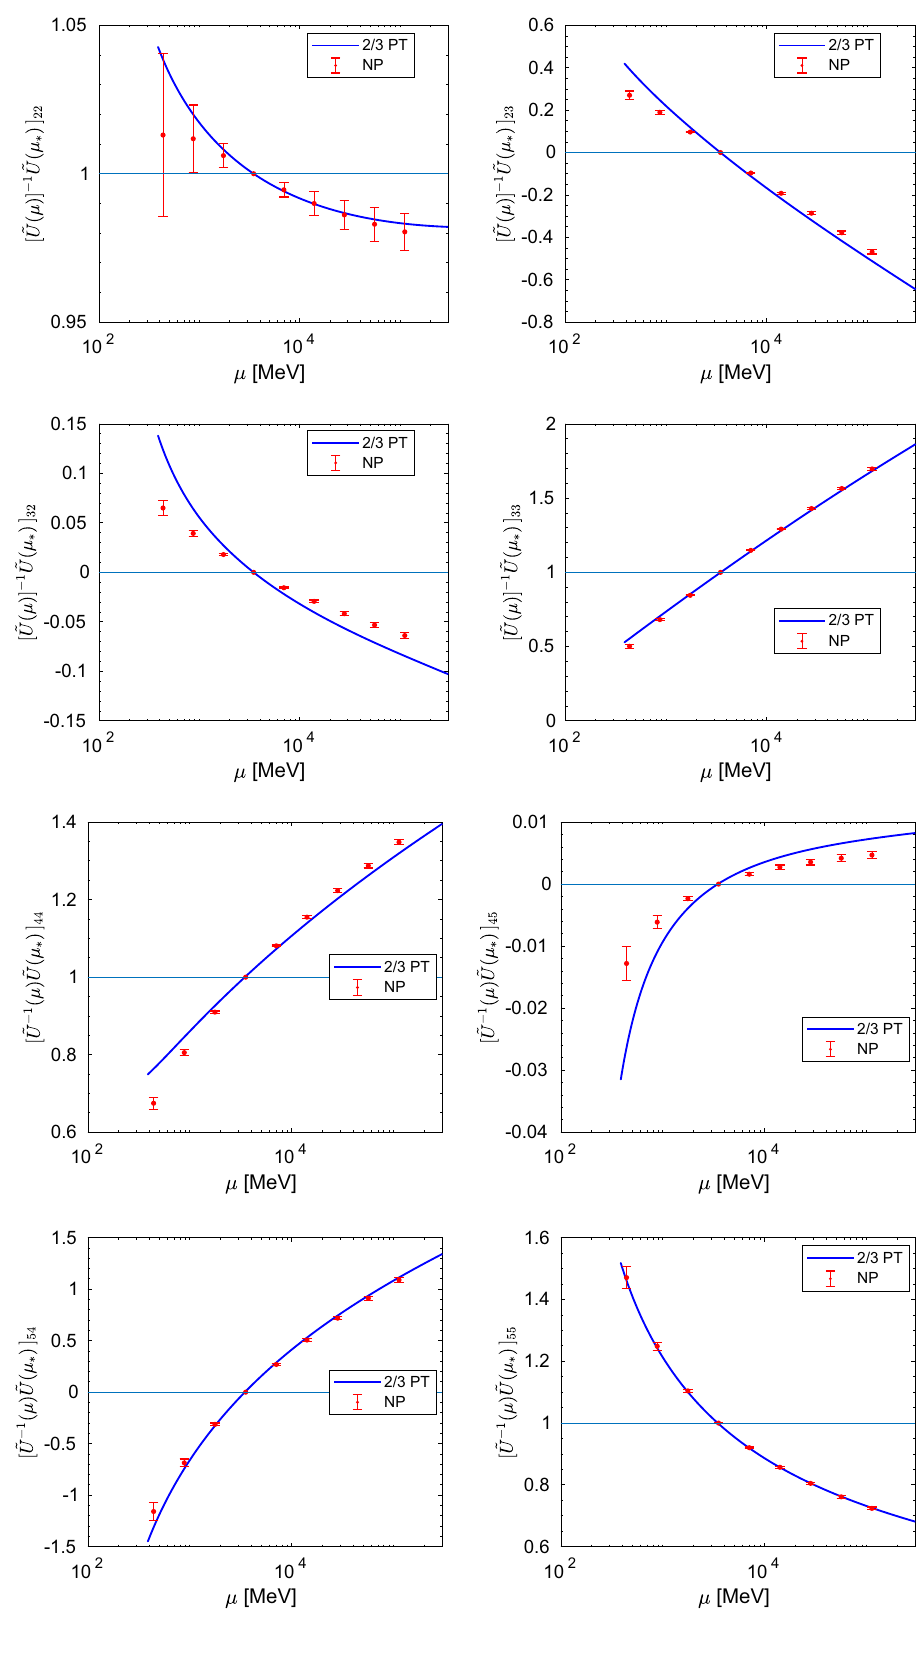
Fig. 12 Non-perturbative evolution factor U + (μ,μ ∗ ) = [ ˜ U + (μ) ] − 1 ˜ U + (μ ∗ ) , where μ ∗ = 3 . 46GeV, for the operator , Q + } (top) and for bases { Q + 2 3 { Q + , Q + } (bottom). Results are 4 5 compared to the perturbative prediction, obtained by numerically integrating Eq. (2.23), with γ (at NLO) and β (at NNLO) in the SF scheme